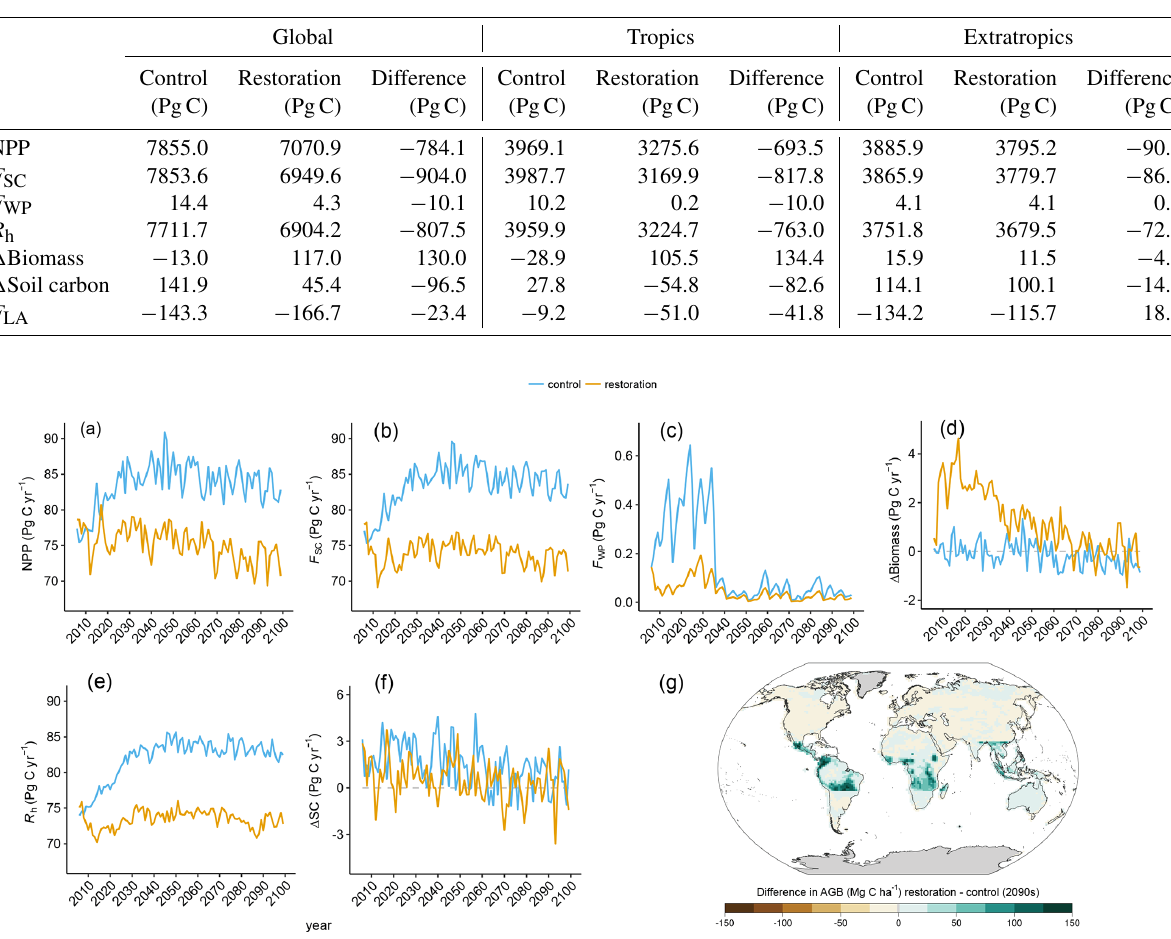
Figure 3. Time series of (a) global net primary production (NPP), (b) global carbon flux into the soil ( F SC ), (c) global carbon flux into the wood product pools ( F WP ), (d) global annual change in aboveground biomass ( (cid:49) Biomass), (e) global soil respiration ( R h ), and (f) global annual change in soil carbon ( (cid:49) SC) in the restoration (yellow) and control (blue) simulation. (g) Spatial difference in biomass between the restoration and control simulations over the 2090s (1MgCha − 1 = 10kgCm − 2